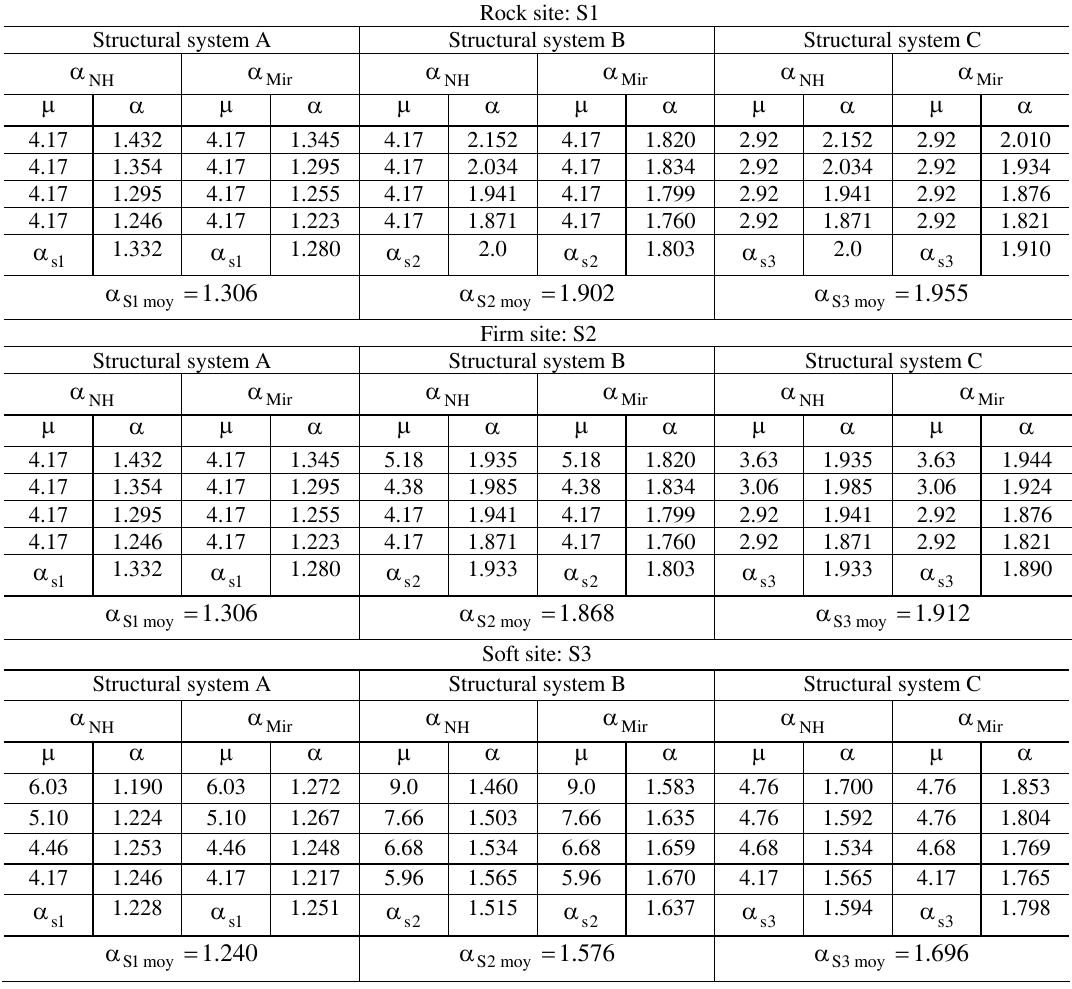
Table 1. Variation of the amplification period coefficient α , while considering site effect